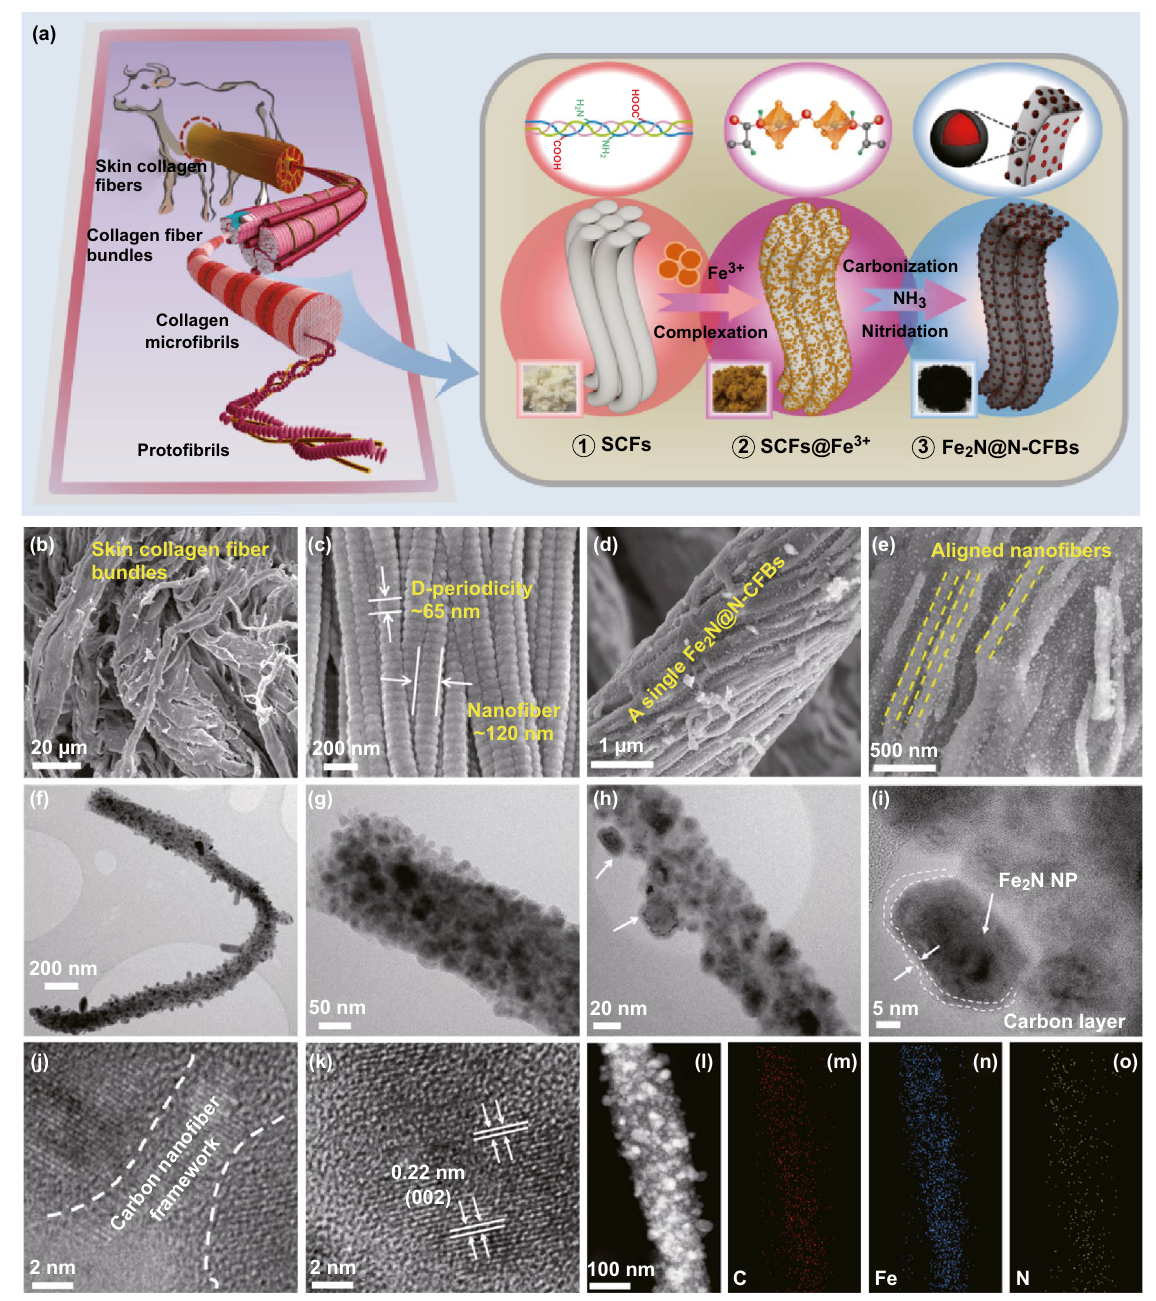
Fig. 1 a Schematic of the structure of the native SCFs and synthesis strategy for Fe 2 N@N-CFBs. FESEM images of b , c natural SCFs and d , e